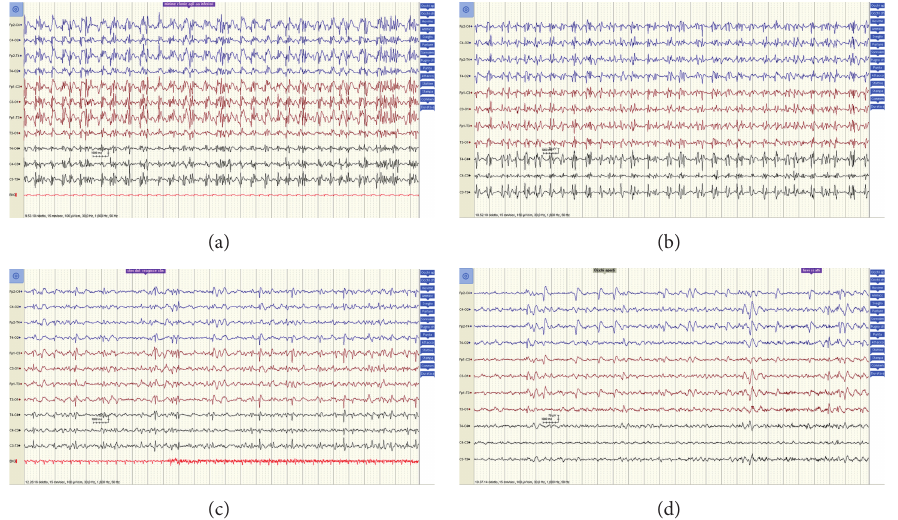
Figure 3: Repeated EEG recordings obtained (a) 4 days, (b) one week, (c) two weeks, and (d) one month after the initial insult confirmed the presence of anomalies, including polyspike-waves, sometimes followed by brief depressions of the electrical activity, even though a tendency toward a gradual quantitative decrease of pathologic potentials was